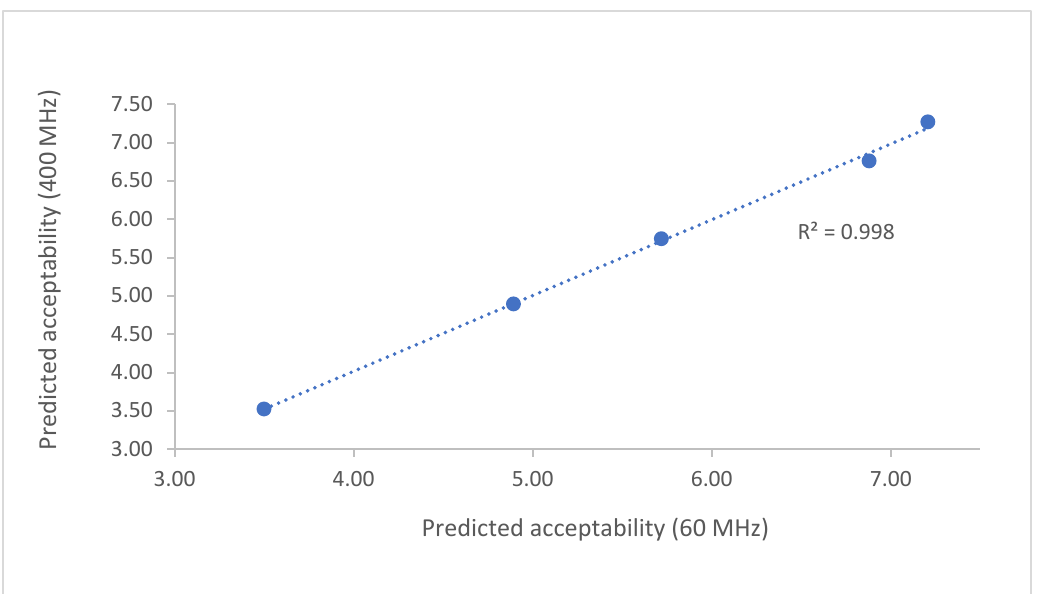
Figure 4. Correlation of the predicted acceptability using the models obtained with both instru- ments.